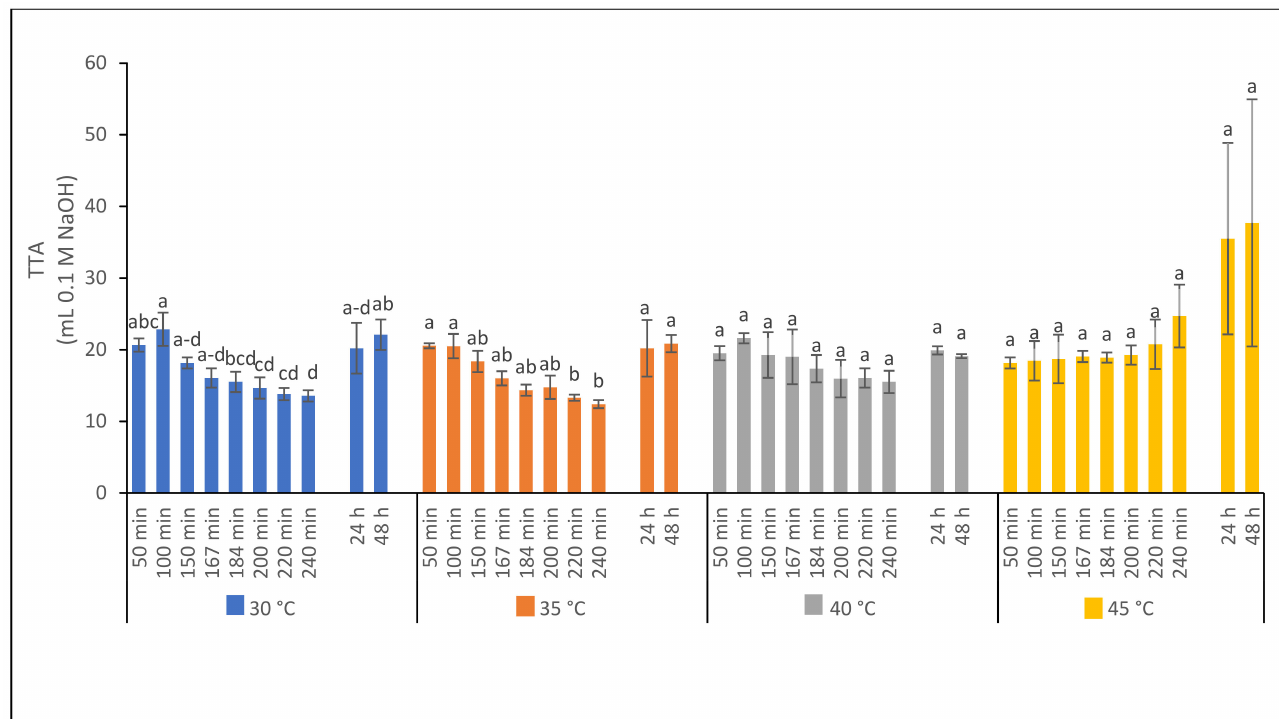
Figure 10. Changes in total titratable acidity of the ferment during fermentation and over a 48 h storage. Bars represent the means and standard deviations of two replication. Bars with different letters indicate significant differences for the results for each fermentation temperature at p < 0.05 (Tukey–Kramer